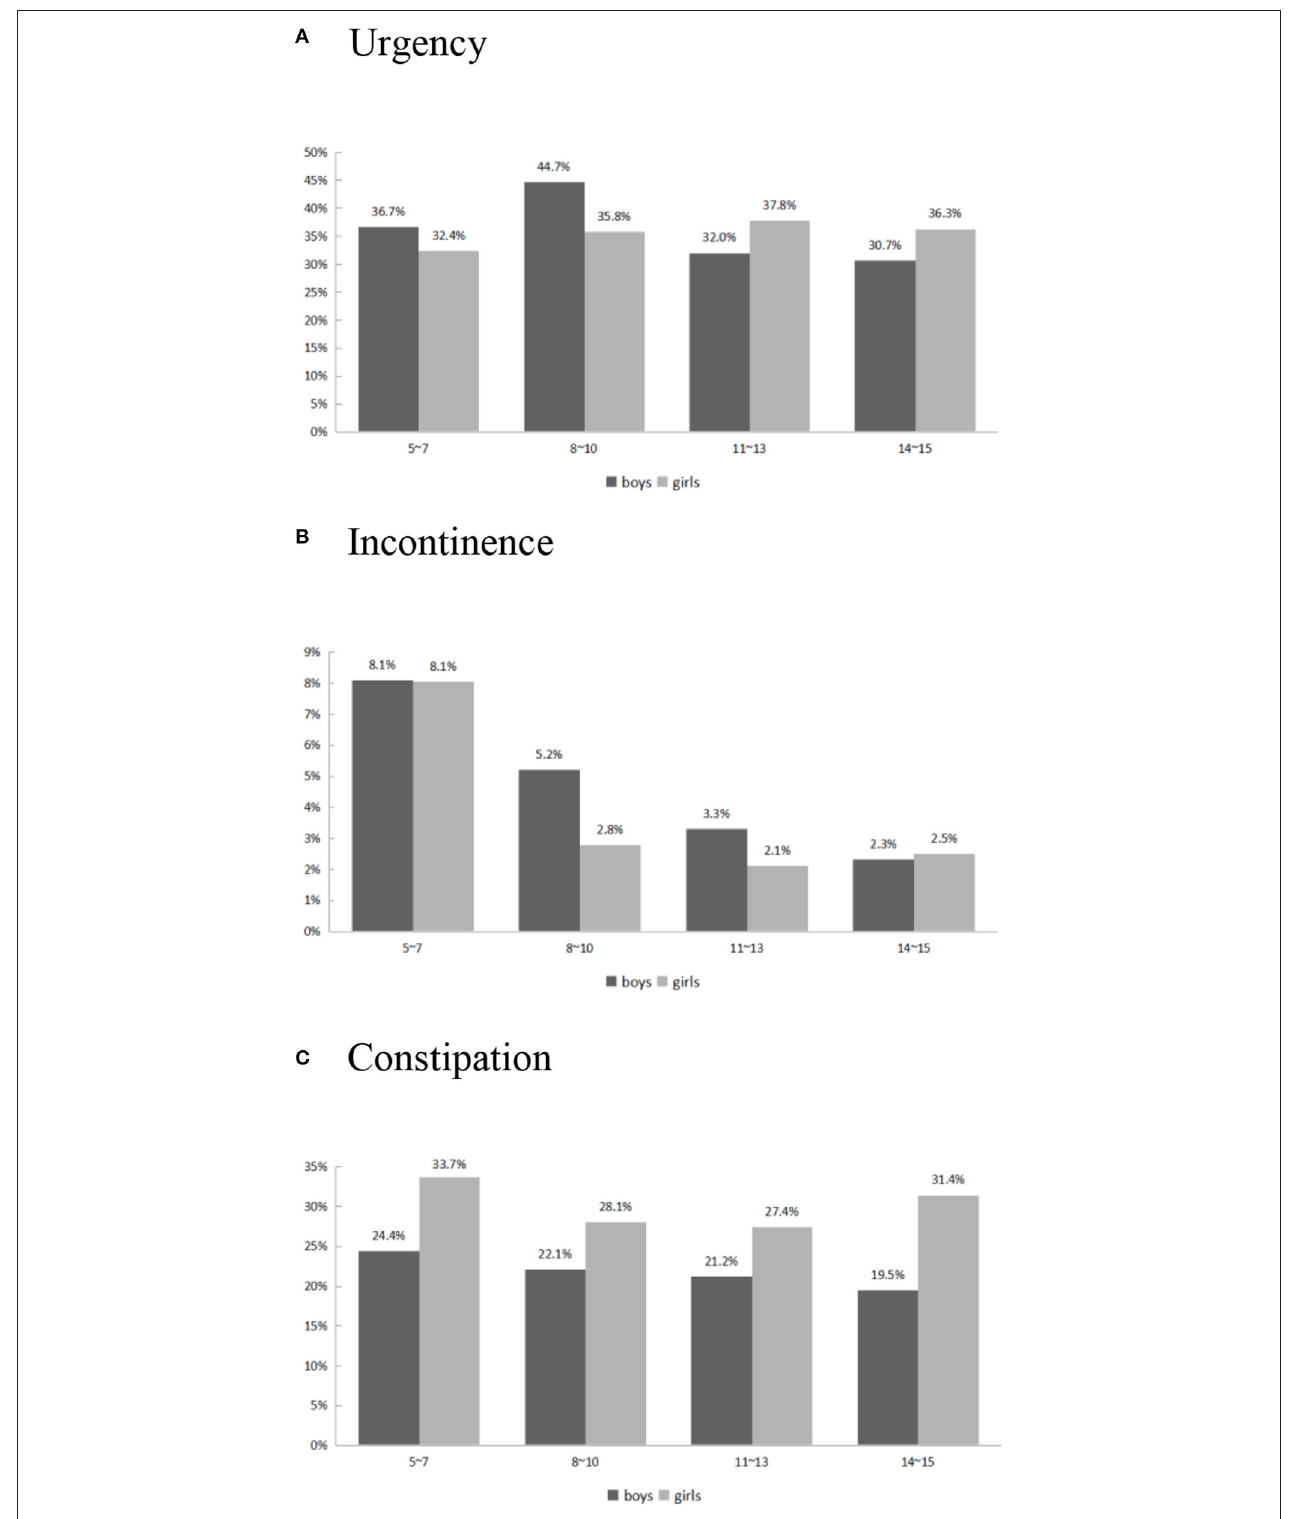
FIGURE 2 | Self-reported Urgency (A) , Incontinence (B) , and Constipation (C) risk vs. age and gender.